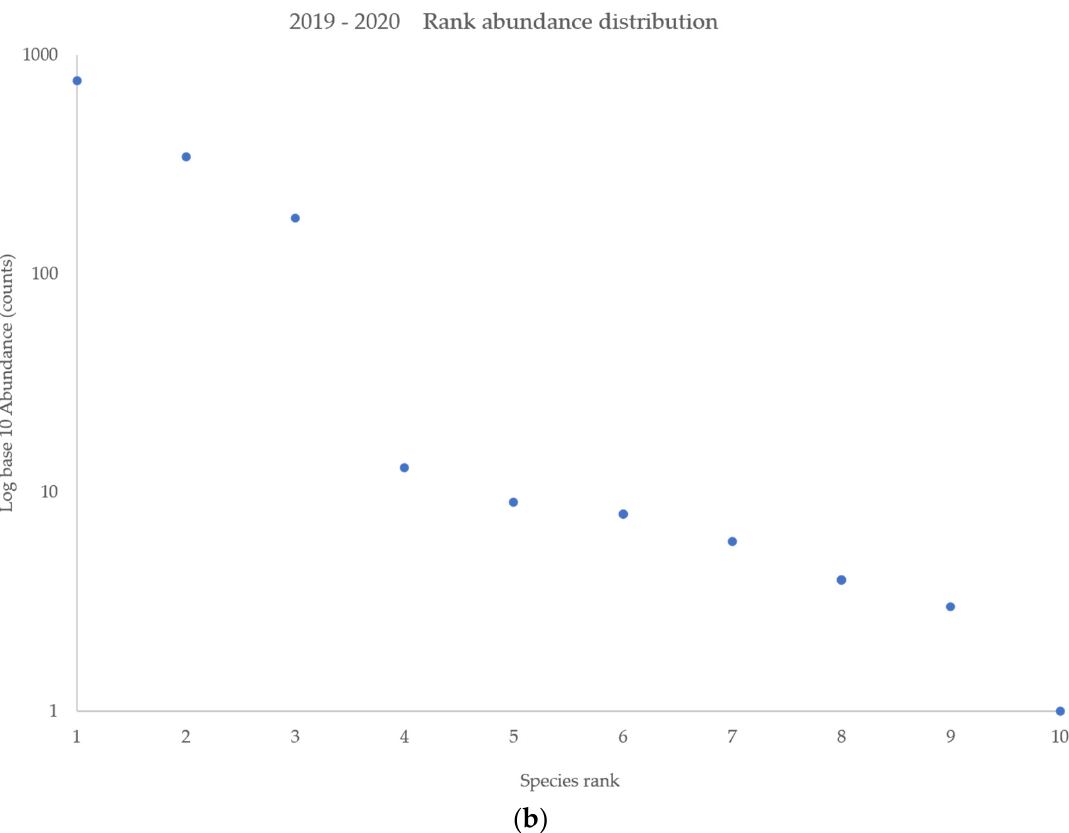
Figure 1. Rank abundance distributions for the ( a ) 1943–1944 survey and ( b ) 2019–2020 survey. Steep gradients are observed in both the 1940s and the present-day surveys, indicating low species evenness due to the much higher abundances of species ranked 1–4 in the 1940s and species ranked 1–3 in the present-day survey.